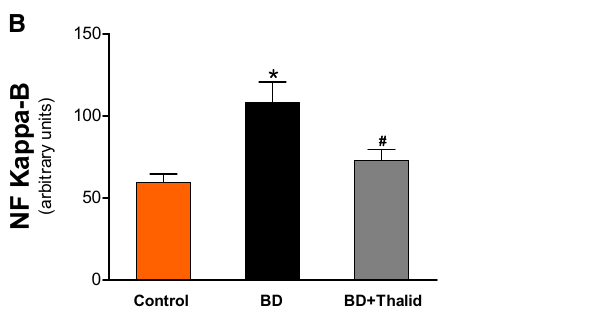
* p<0.05 vs. Control group # p<0.05 vs. BD group